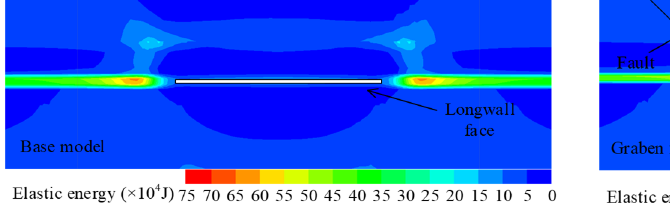
( b ) Figure 6. Vertical displacement distribution contour (cross-section of 30 m behind the longwall face). ( a ) Base model; ( b )